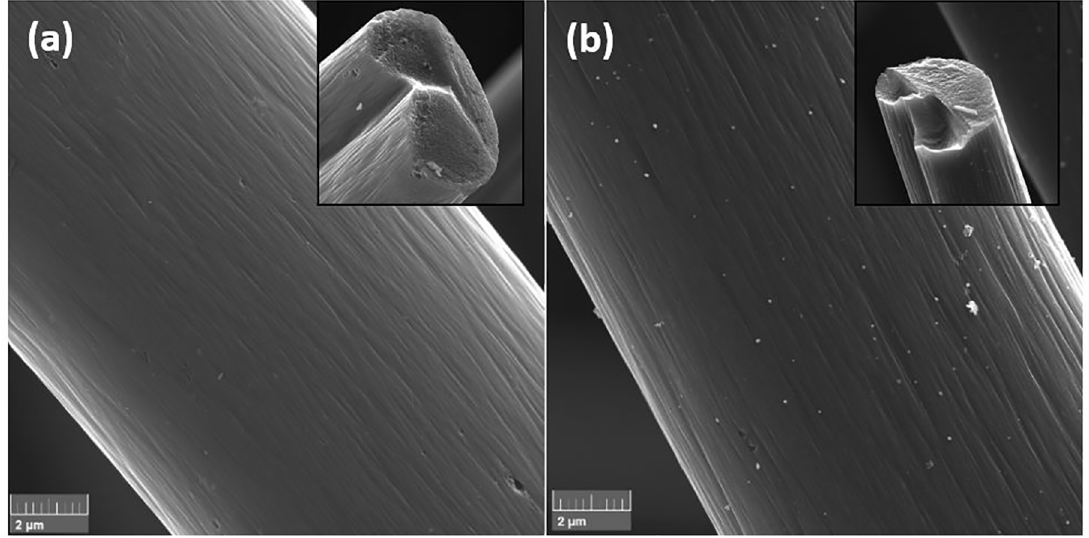
Figure 1. FEG-SEM images obtained for the samples at 20.000 of magnifications, and inset filament tip of (a) ACF and, (b) Ag@ACF.